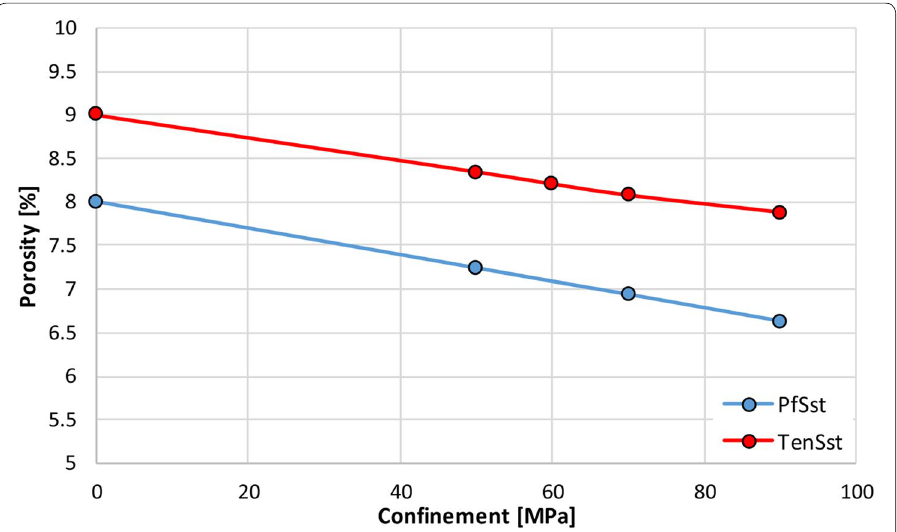
Fig. 8 Porosity changes under hydrostatic conditions for PfSst and